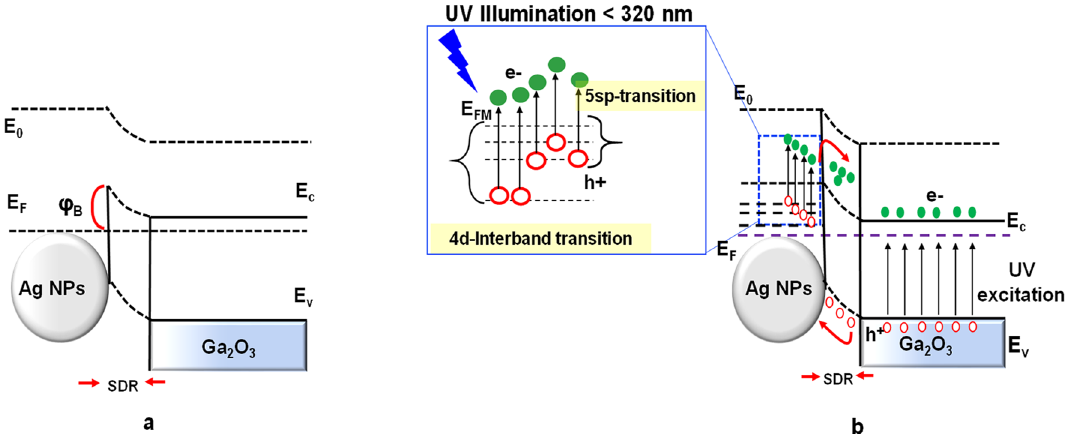
Figure 17. Energy band diagram at the interface of Ag NPs and Ga 2 O 3 NWs. ( a ) In dark condition, a localized Schottky barrier exists due to the difference in work-function. ( b ) Under UV illumination, the interband transition in Ag NPs enhances the photosensitivity of the UV detection and more photo-generated holes of Ga 2 O 3 NWs migrate to the surface by band